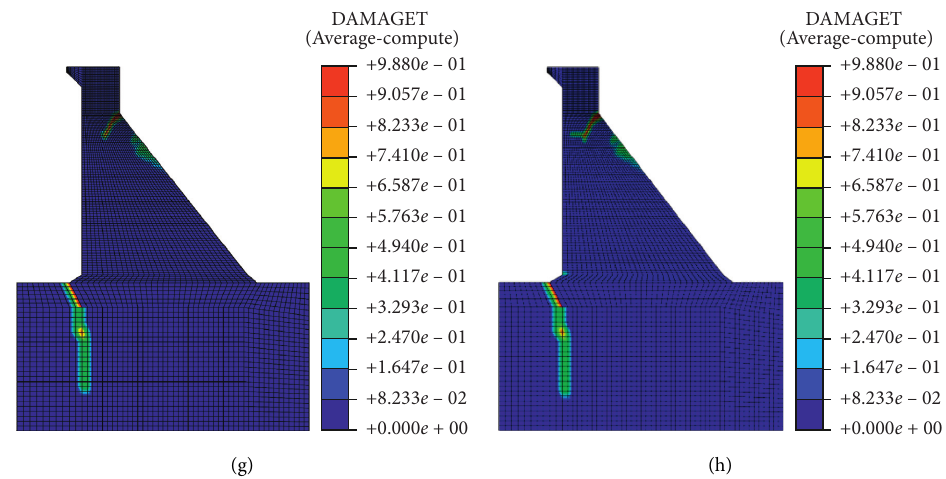
Figure 8: Dam damage zone under single main shock and main-aftershock. P represents the transcendence probability of aftershock PGA.. (a) Single main shock action. (b). P � 60%. (c) P � 40%. (d) P � 30%. (e) P � 25%. (f) P � 20%. (g) P � 15%. (h) P �